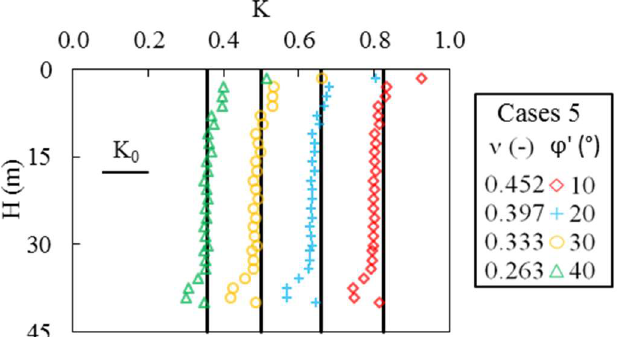
Figure 4. Distribution of K along the VCL of backfilled openings as a function of ϕ’ and ν (Cases 5 in Table 1).